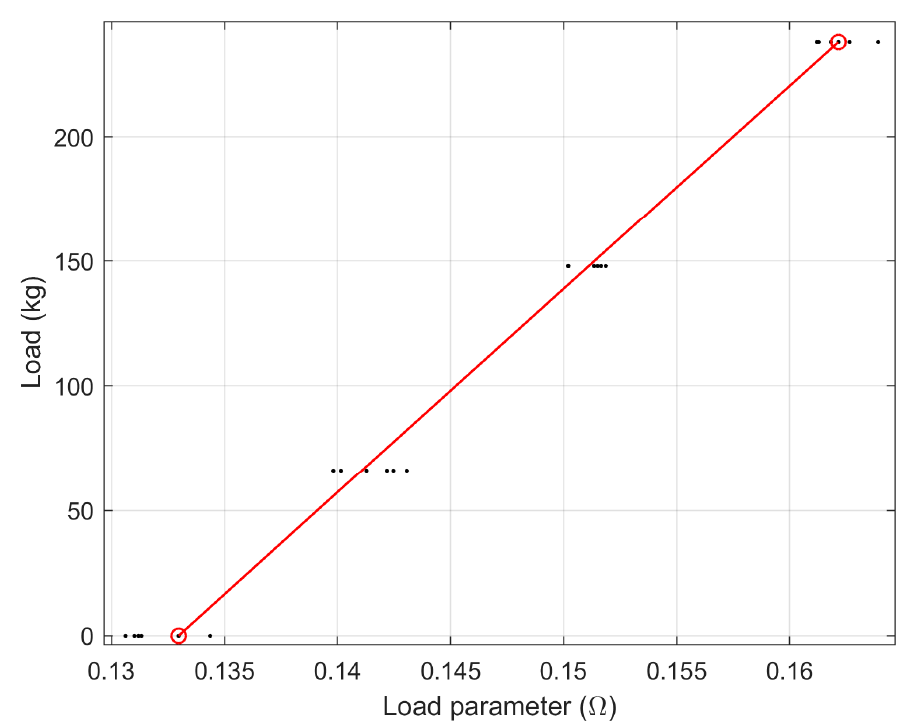
Figure A5. Dependencies between a car load and the load parameter for a three-door Volkswagen Polo. Dots represent measurements; circles stand for chosen to calibrate values of the measured load parameter (for a car and load); and line show the least squares fit to the chosen measurements (i.e., circles).